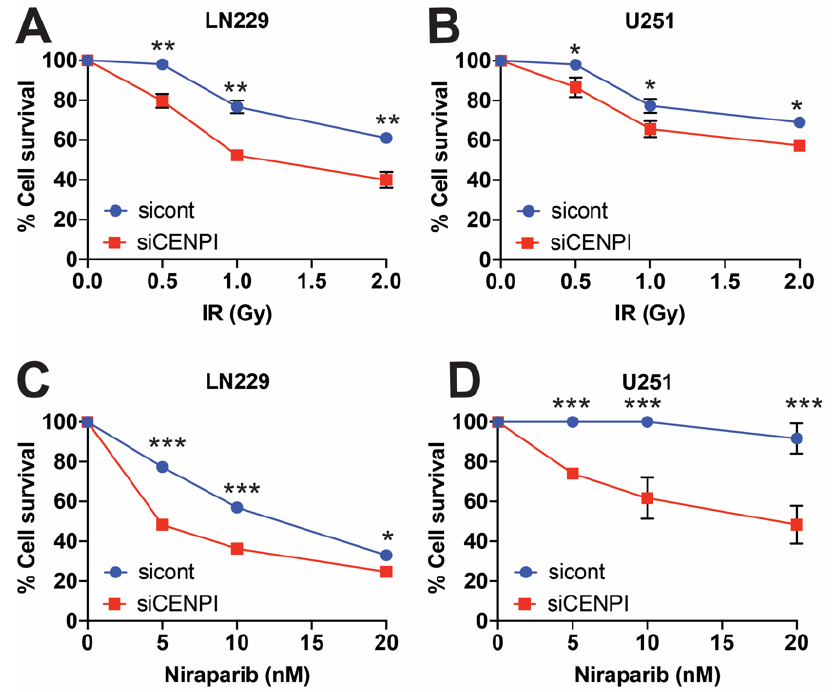
Figure 2. Loss of CENP-I sensitizes cells to genotoxic stress. ( A , B ) LN229 and U251 cells with and without CENP-I were exposed to indicated doses of ionizing radiation (IR). ( C , D ) LN229 and U251 cells were treated with indicated doses of Niraparib. Statistical analysis was performed using S tudent’s t -test. * = p ≤ 0.05, ** = p ≤ 0.01, *** = p ≤